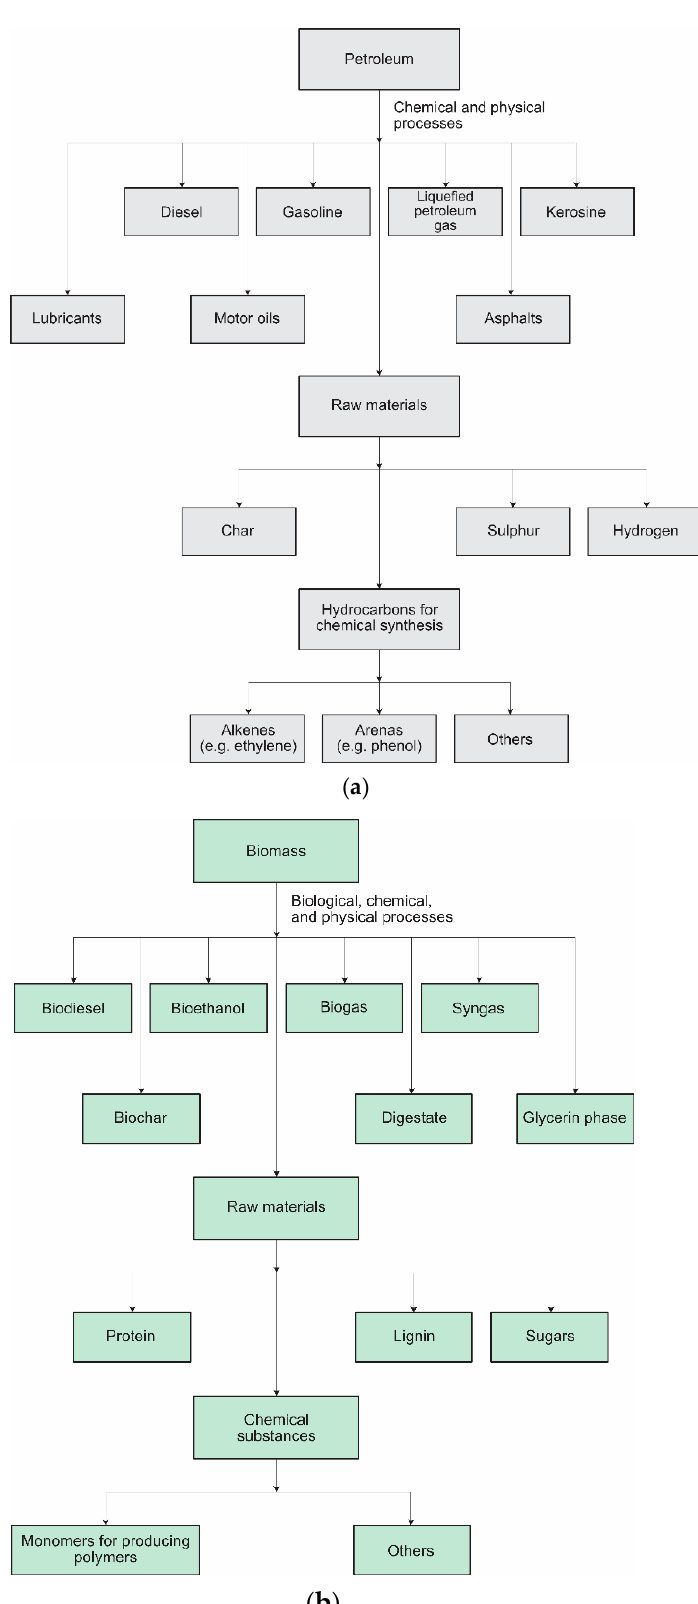
Figure 6. Products obtained from: ( a ) oil refineries and ( b ) biomass refineries.